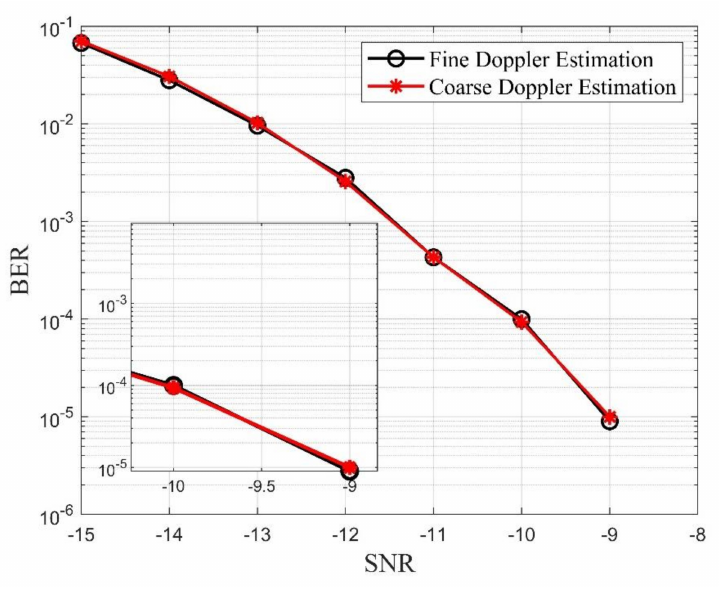
Figure 9. Comparison of BER between coarse Doppler estimation and fine Doppler estimation based